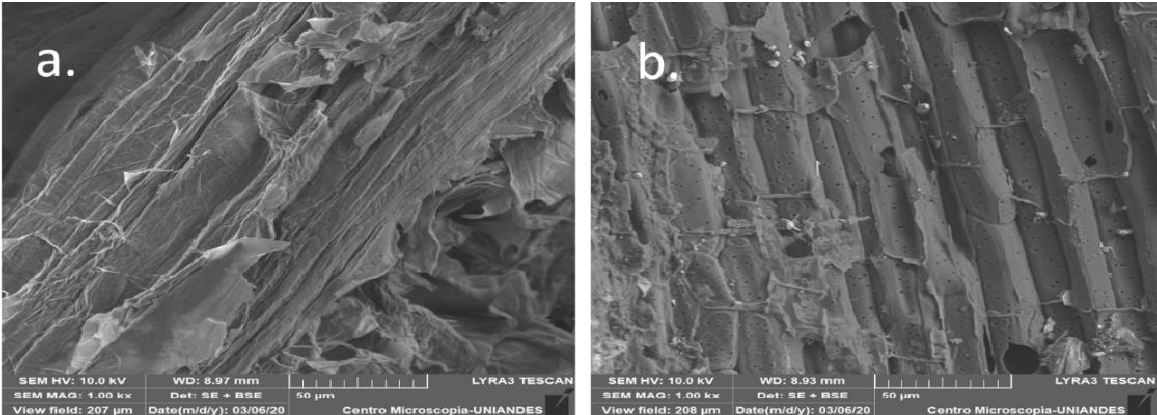
Figure 3. SEM micrographs of ( a ) the chemically modified cellulose (MC) and ( b ) the biochar prepared by impregnation with H 2 SO 4 B 1:1.